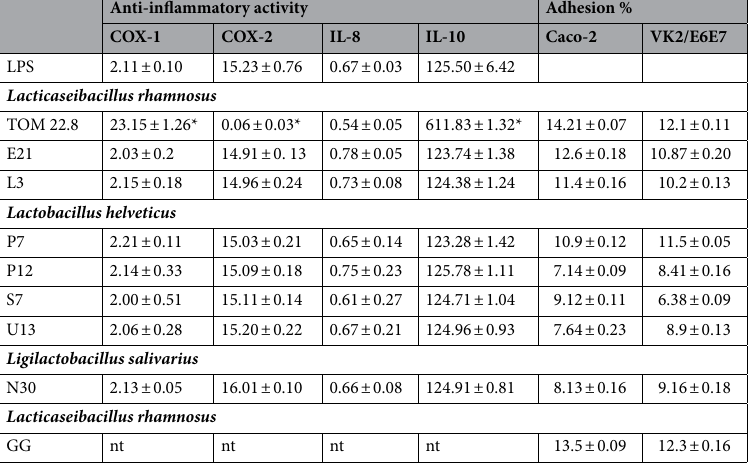
Table 3. Gene levels expression of COX-1, COX-2, IL-8, and IL-10 in differentiated human macrophages and adhesion (%) of lactobacilli to Caco-2 and to VK2/E6E7 vaginal epithelial cells. Adhesion to Caco-2 and to VK2/E6E7 vaginal epithelial cells are expressed as percentage (%). The adhesion abilities of the E21, L3, P7, P12, S7, U13, and N30 strains was already published 23 . COX-1,COX-2,IL-8, and IL-10 data are expressed as increased fold compared to untreated cells and standard deviation; nt not tested. * P < 0.05 respect to lipopolysaccharide (LPS) treatment.